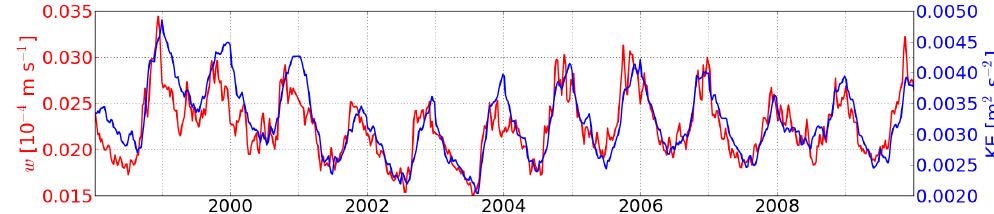
Figure 5. Time series of vertical velocity magnitude (red line) and kinetic energy (blue line) averaged over the area of study. The correlation coefficient between vertical velocity and kinetic energy is 0.84.